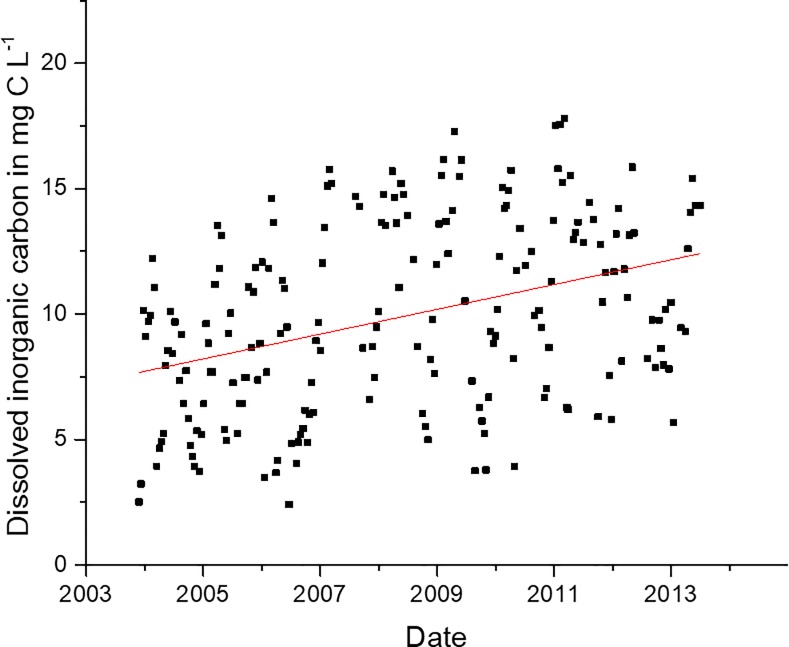
Dissolved inorganic carbon at station 70S recorded during the duration of the study.The slope of the linear fit of data (red line) is significantly different from zero (p<0.05, r2 = 0.12).